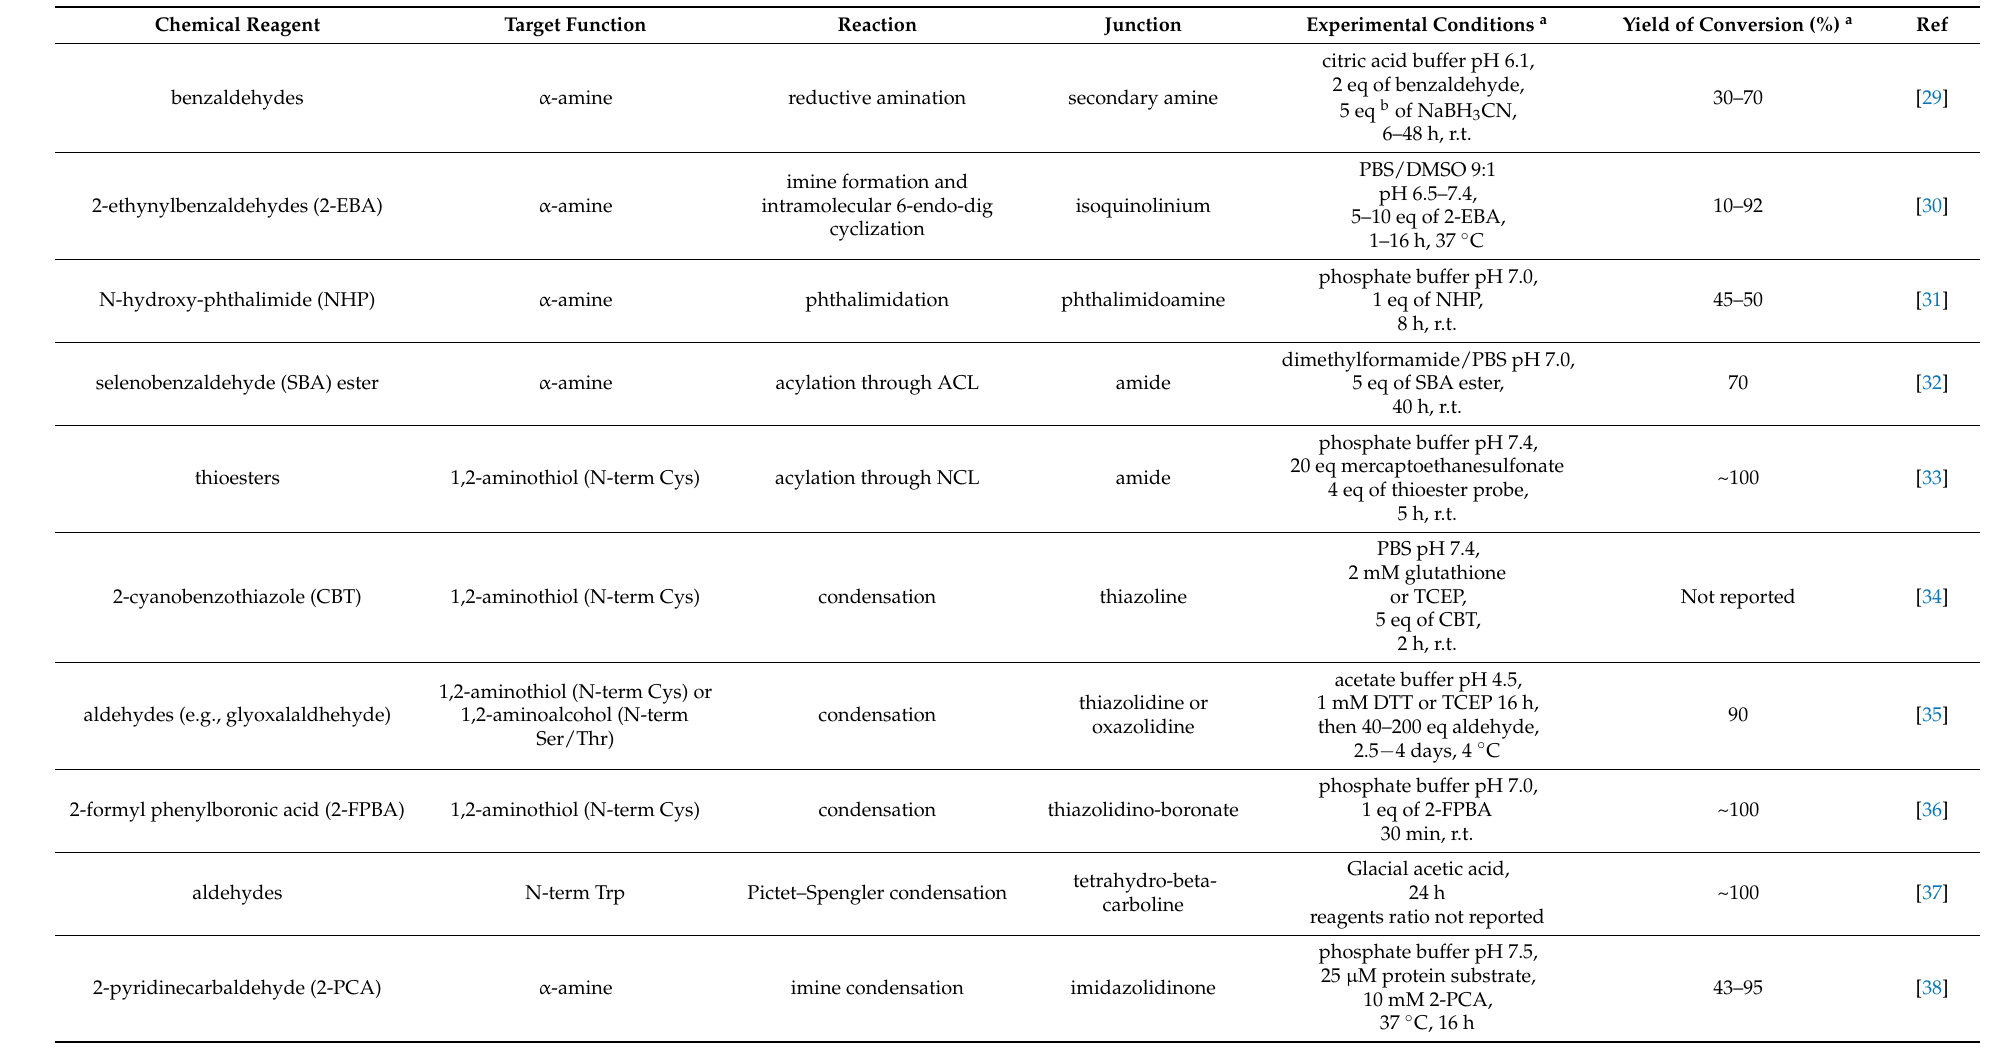
Table 1. Chemical strategies developed for site-specific protein bioconjugation through the targeting of the N-terminal